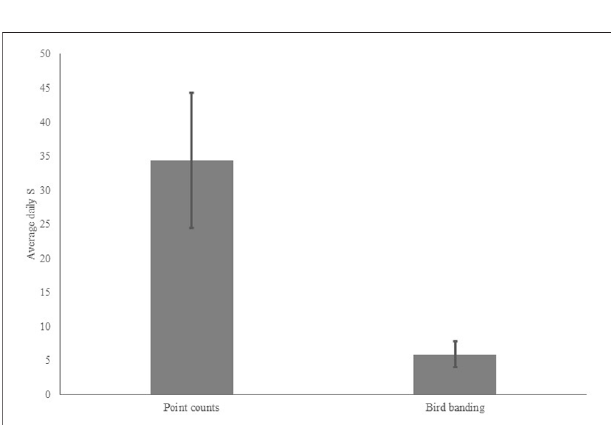
FIGURE 4 | Average daily species richness of point counts versus bird banding (Kruskal – Wallis chi-squared = 47.676, df = 1, p -value < 0.00001).